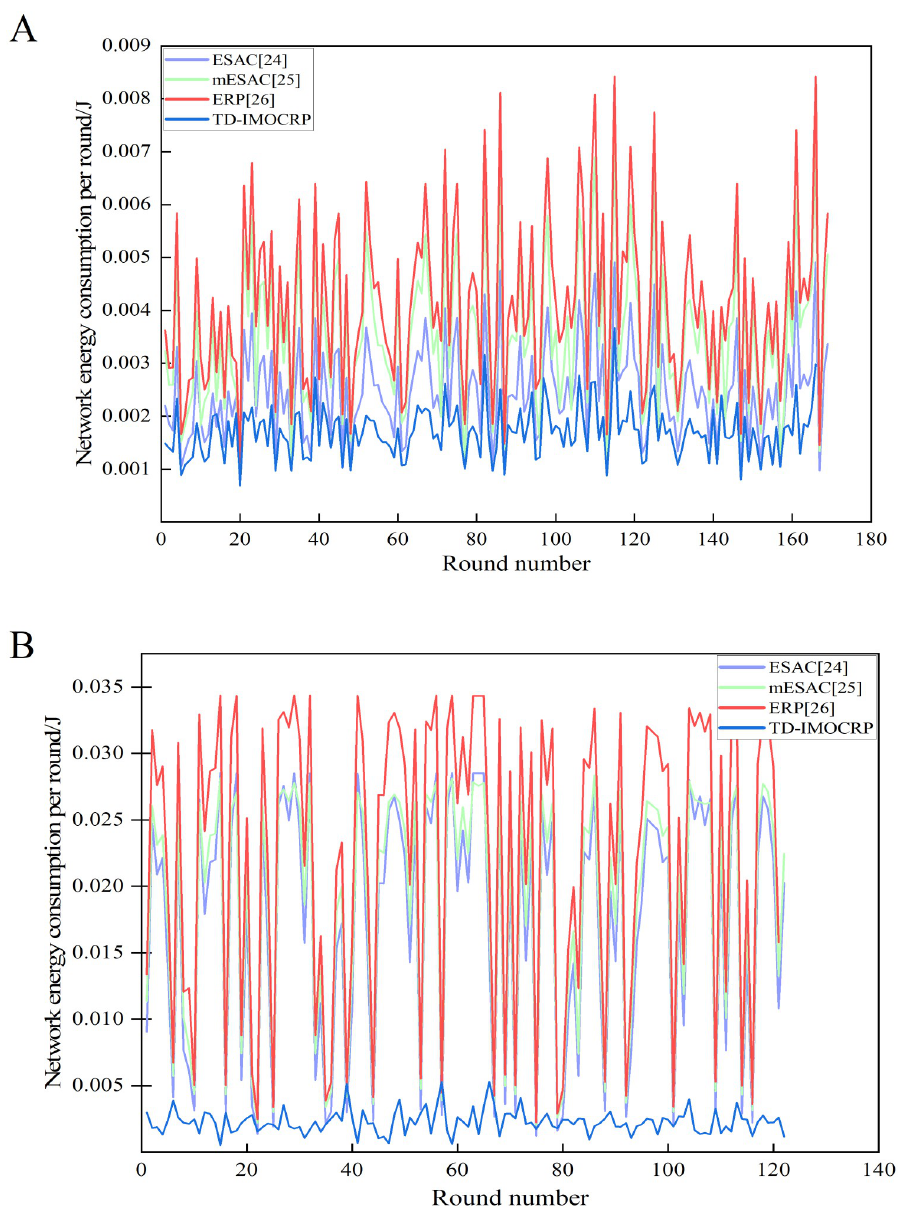
Fig 10. Comparison results of network energy consumption per round. (A) The sink is located at the center. (B) The sink is located at (0,0).